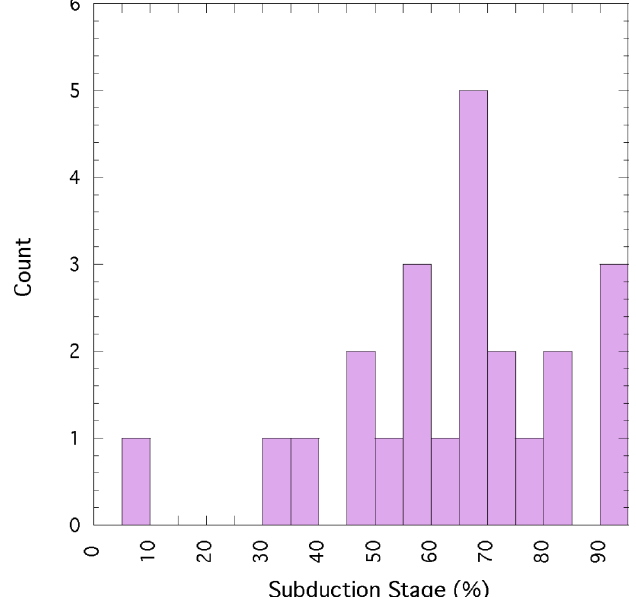
Figure 11. Frequency of preservation of rocks formed during the subduction stage of Proterozoic orogens (data from Appendix 1, col AG). The ratio is calculated from a combination of igneous zircon ages and areal distributions of igneous rocks as estimated from geologic maps.